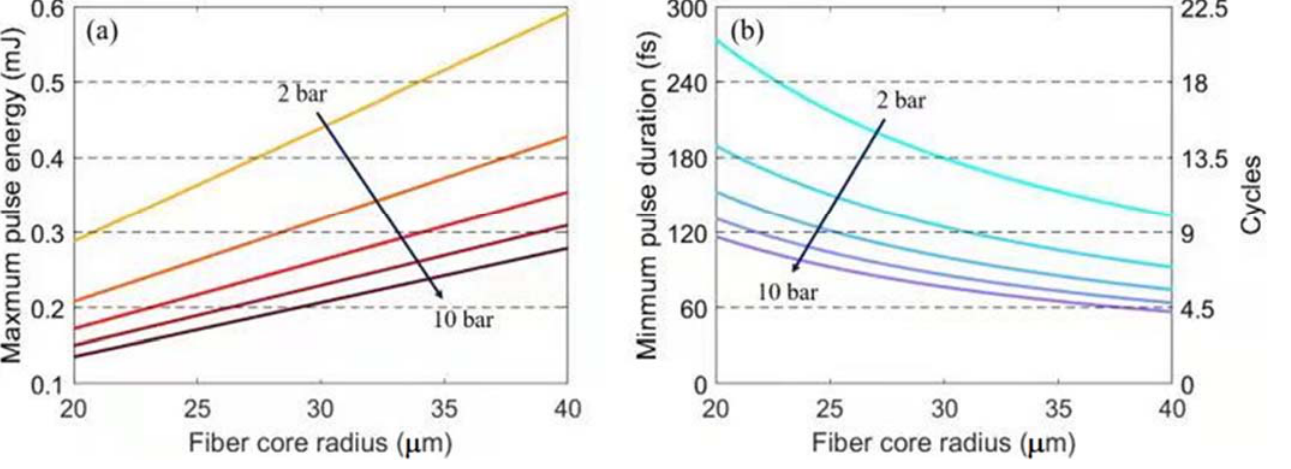
Figure 2. Dependence of E max ( a ) and T min ( b ) on the HCF core radius with the helium pressure at 2 bar, 4 bar, 6 bar, 8 bar, and 10 bar. The pulse is centered at 4 μ m.